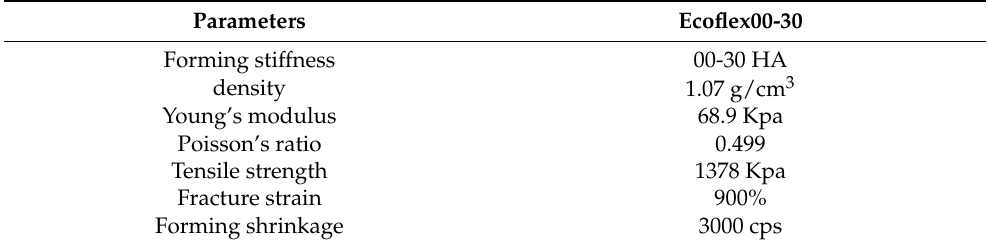
Table 2. Ecoflex00-30 material parameters. Parameters